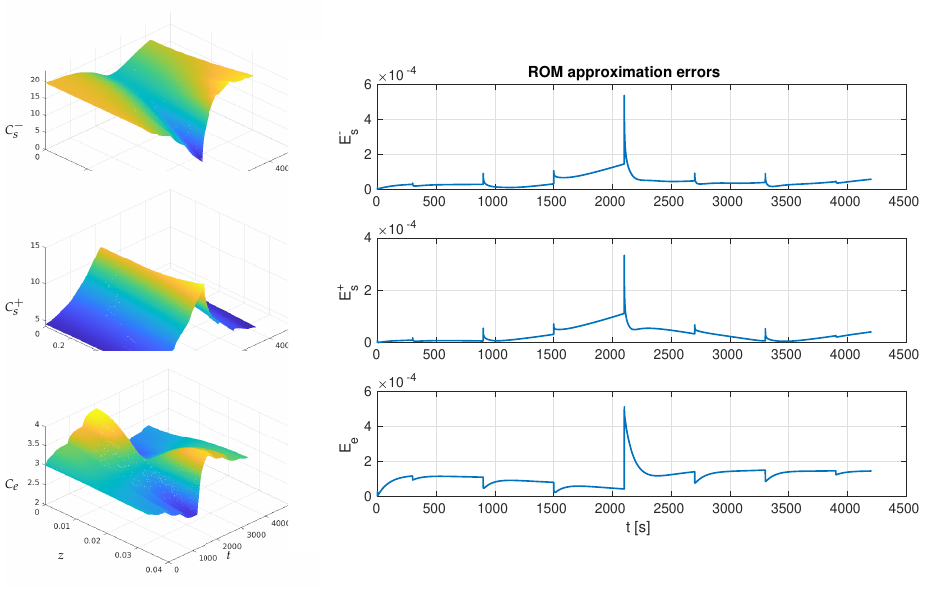
Figure 3. ROM approximation of concentration profiles ( left column) for negative electrode ( top ), pos- itive electrode ( center ) and electroylte ( bottom ), with the associated approximation error evolutions over time ( right